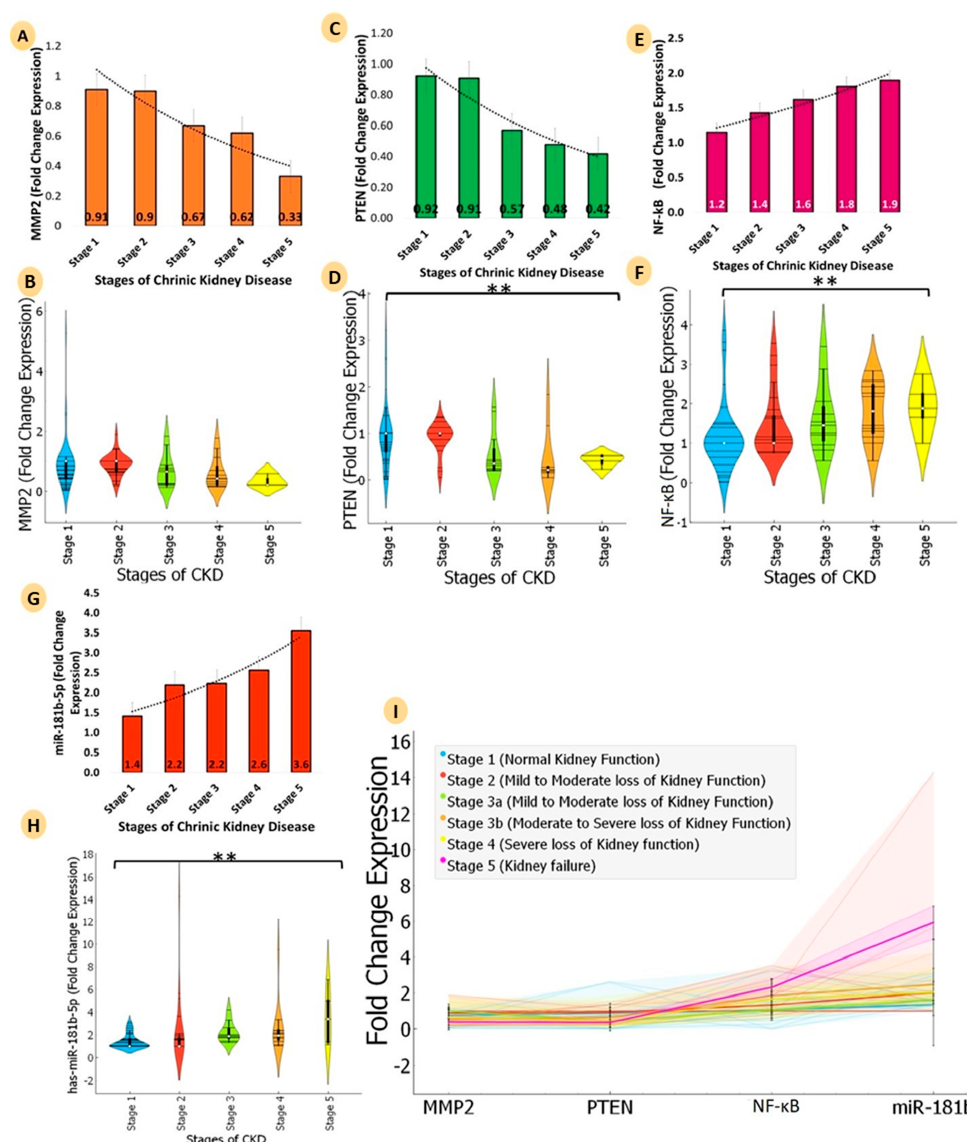
Figure 4. Comparative analyse the mRNA expression of three genes (PTEN, MMP2, and NF- κ B) and microRNA-181b-5p for five stages of chronic kidney disease (stage 1: normal kidney